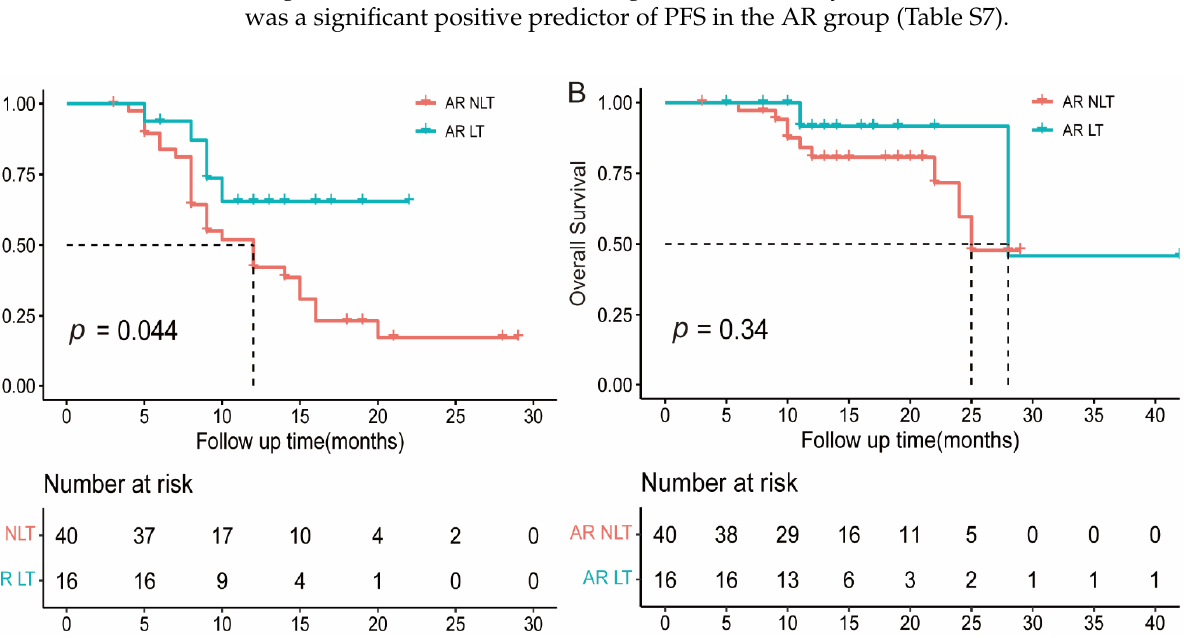
Figure 4. Kaplan–Meier analysis of PFS ( A ) and OS ( B ) in patients with AR who received local therapy or not. AR, atypical response; NLT, non-local therapy; and LT, local therapy.